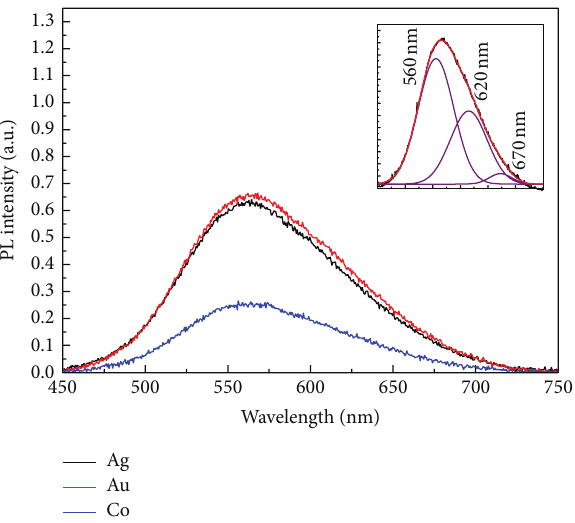
Figure 4: PL spectra for nanoparticle/HOPG composites. Inset: Gaussian spectrum deconvolution.